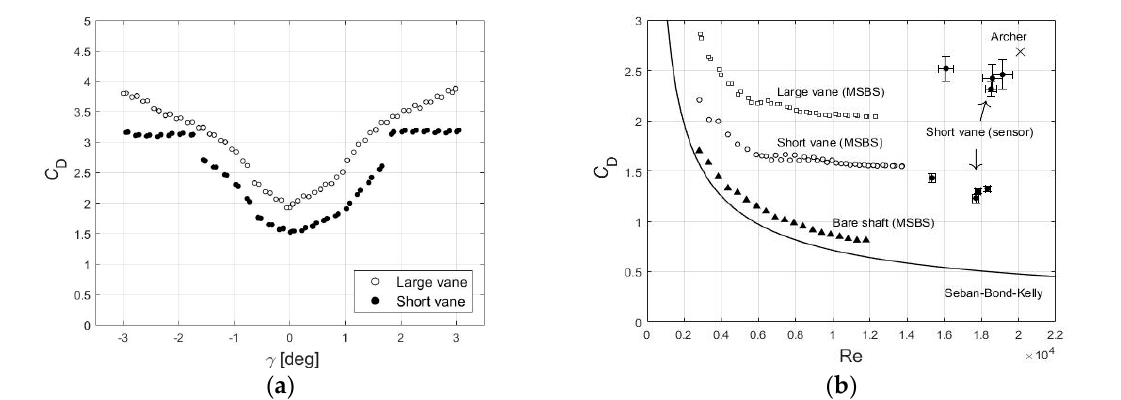
Figure 3. ( a ) C D as a function of γ at Re = 1.0 × 10 4 ; ( b ) C D as a function of Re obtained from the Magnetic Suspension and Balance System (MSBS) tests and the acceleration